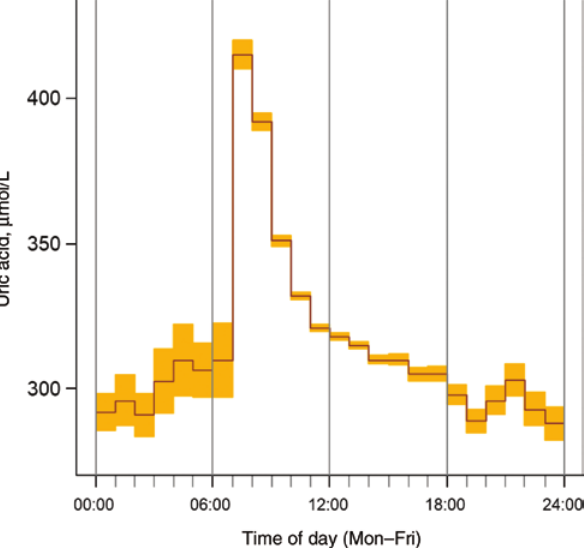
Figure 2: Diurnal variation of the uric acid concentration in heparinised plasma (ambulant patients, laboratory 3, n = 80,099). Daily observations are calculated during 1 week and the medians from Monday to Friday are presented. The yellow areas represent the approximate 95% confidence limits based on the median absolute deviation.